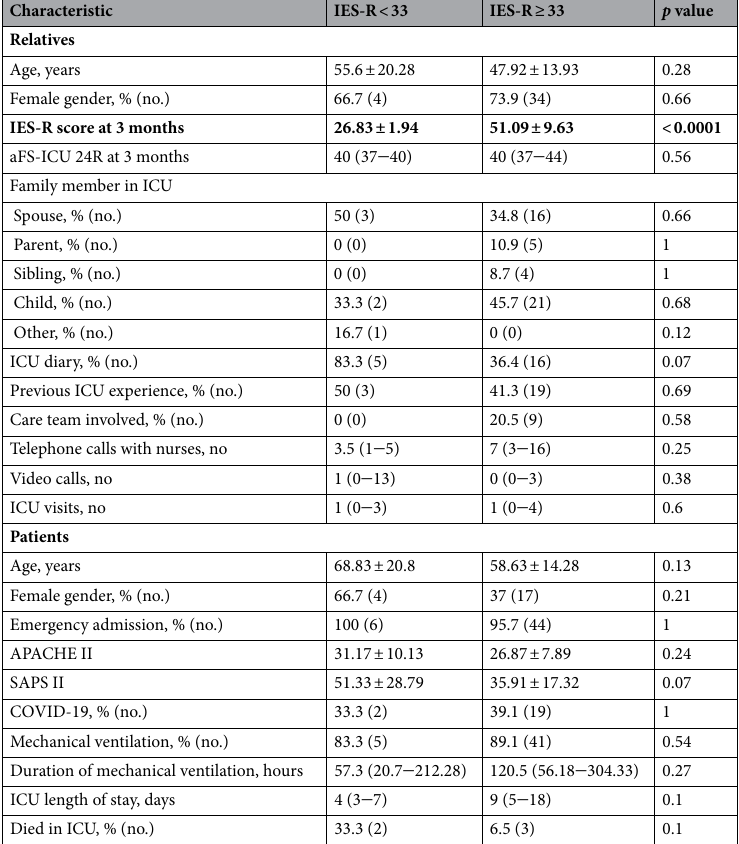
Table 2. Comparison of characteristics related to IES-R score at 3 months after ICU stay. Significant values are in bold. Relatives’ age, family satisfaction score, patients’ age, duration of mechanical ventilation, and length of stay expressed as median and interquartile range; IES-R score, Acute Physiology and Chronic Health Evaluation II (APACHE II) score, and Simplified Acute Physiology Score II (SAPS II) expressed as mean and standard